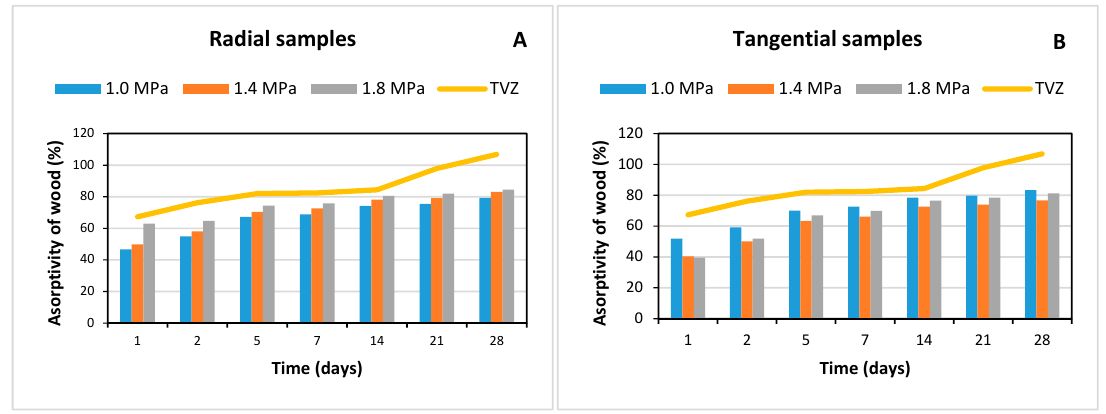
Figure 12. Development of the absorptivity of wood at time in the case of the ( A ) radial and ( B ) tangential samples.